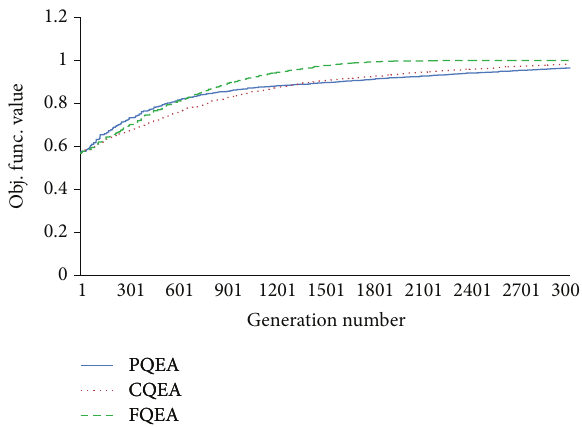
Figure 16: Convergence graph of PQEA, CQEA, and FQEA on 𝑃 - PEAKS problem of size, 𝑁 , being 1000 and number of peaks, 𝑃 , being 100.